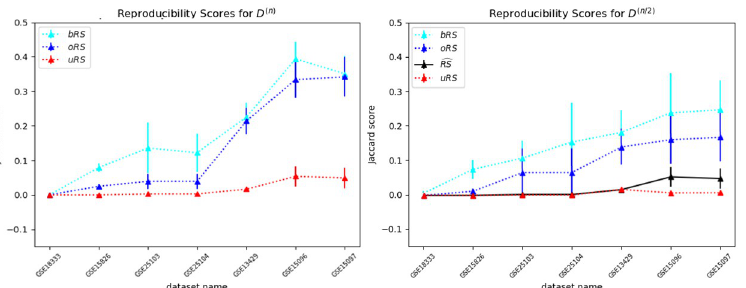
Fig 8. Empirical results for SNP datasets. Reproducibility scores (mean and standard deviation) for 7 SNP datasets, both for complete datasets with n subjects D ( n ) (left) and for half-sized with n subjects D ( n /2) (right), for 50 iterations. 2 The x-axes (for both plots) is sorted by the value of the overbound oRS for the D ( n ) datasets. We see, in both, that the over-bound oRS is consistently higher than the under-bound uRS. Moreover, the right plot shows that the “truth” c RS is also within the range of oRS and uRS. (The bRS lines in the plots are based on the Bootstrap Overbound method; see Section C.1 in S1 Appendix).